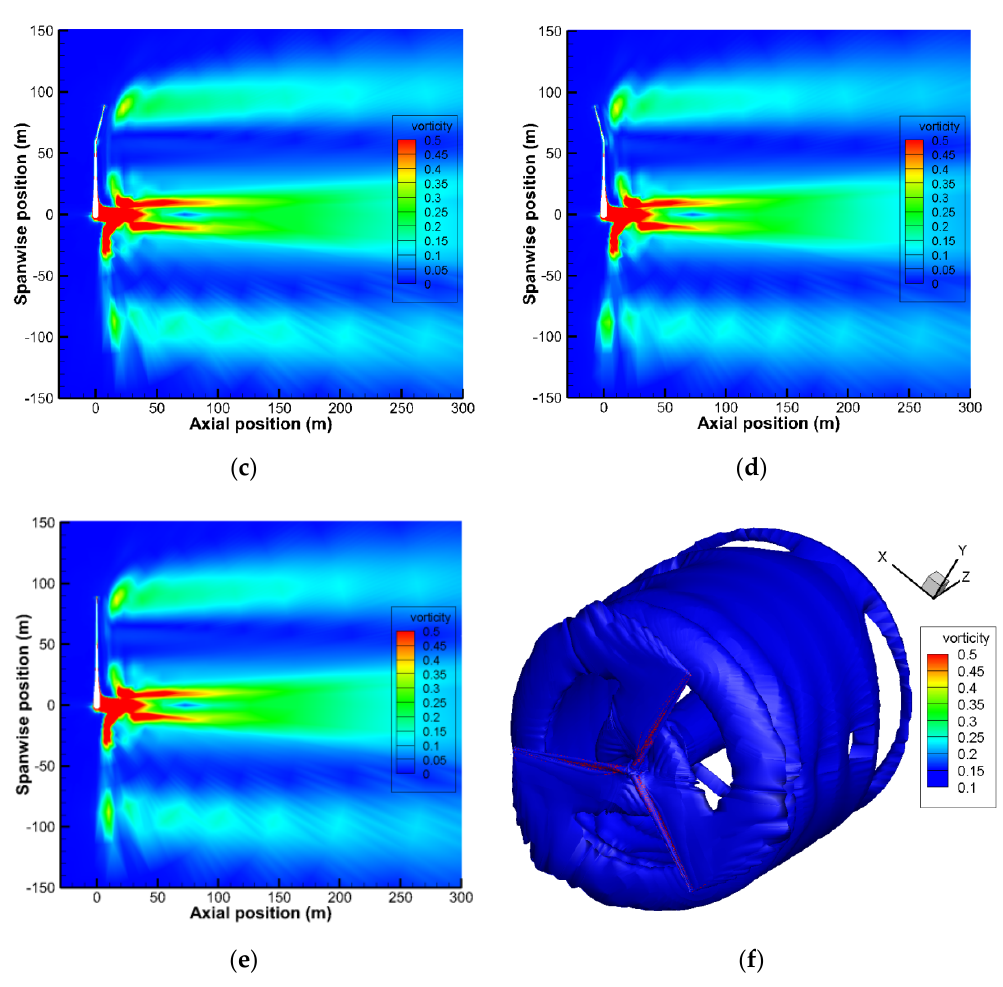
Figure 15. The vorticity contour on plane x = 0 m: ( a ) rotor of T trans = 1/3 and C cone = 8; ( b ) rotor of T trans = 1/3 and C cone = − 8; ( c ) rotor of T trans = 2/3 and C cone = 4; ( d ) rotor of T trans = 2/3 and C cone = − 4; ( e ) straight rotor; ( f ) vorticity isosurface of straight rotor.